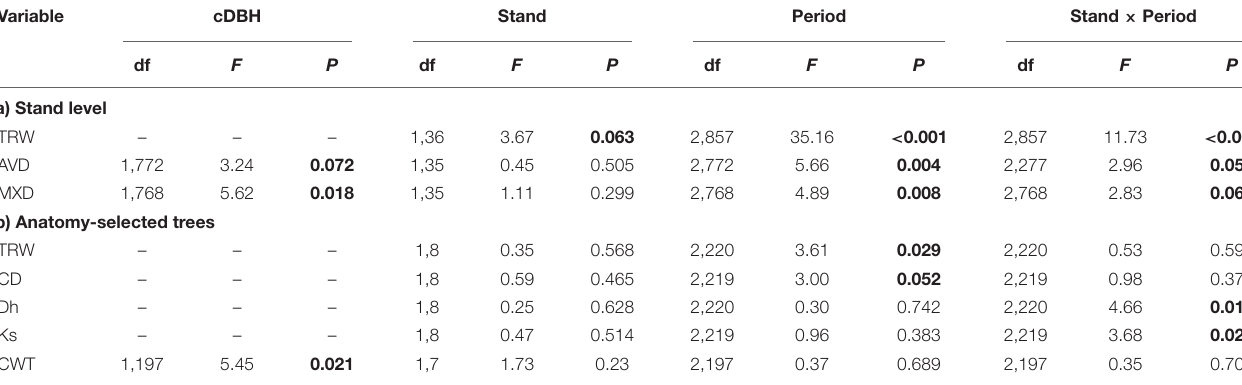
TABLE 1 | Results of the ANOVA tests for each variable at (a) stand level and for the (b) anatomy-selected